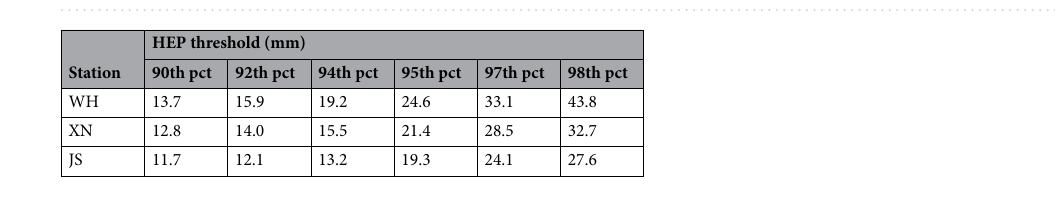
Table 1. Summer HEP thresholds at WH, XN and JS stations for different